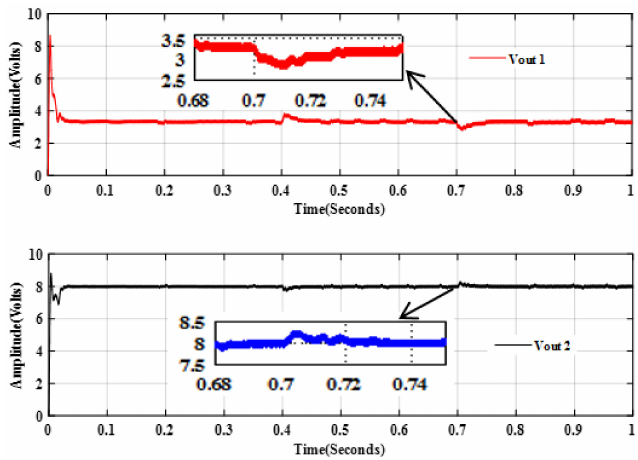
Figure 9. Closed loop response of the DIDO converter with Multivariable PID controller with load and line